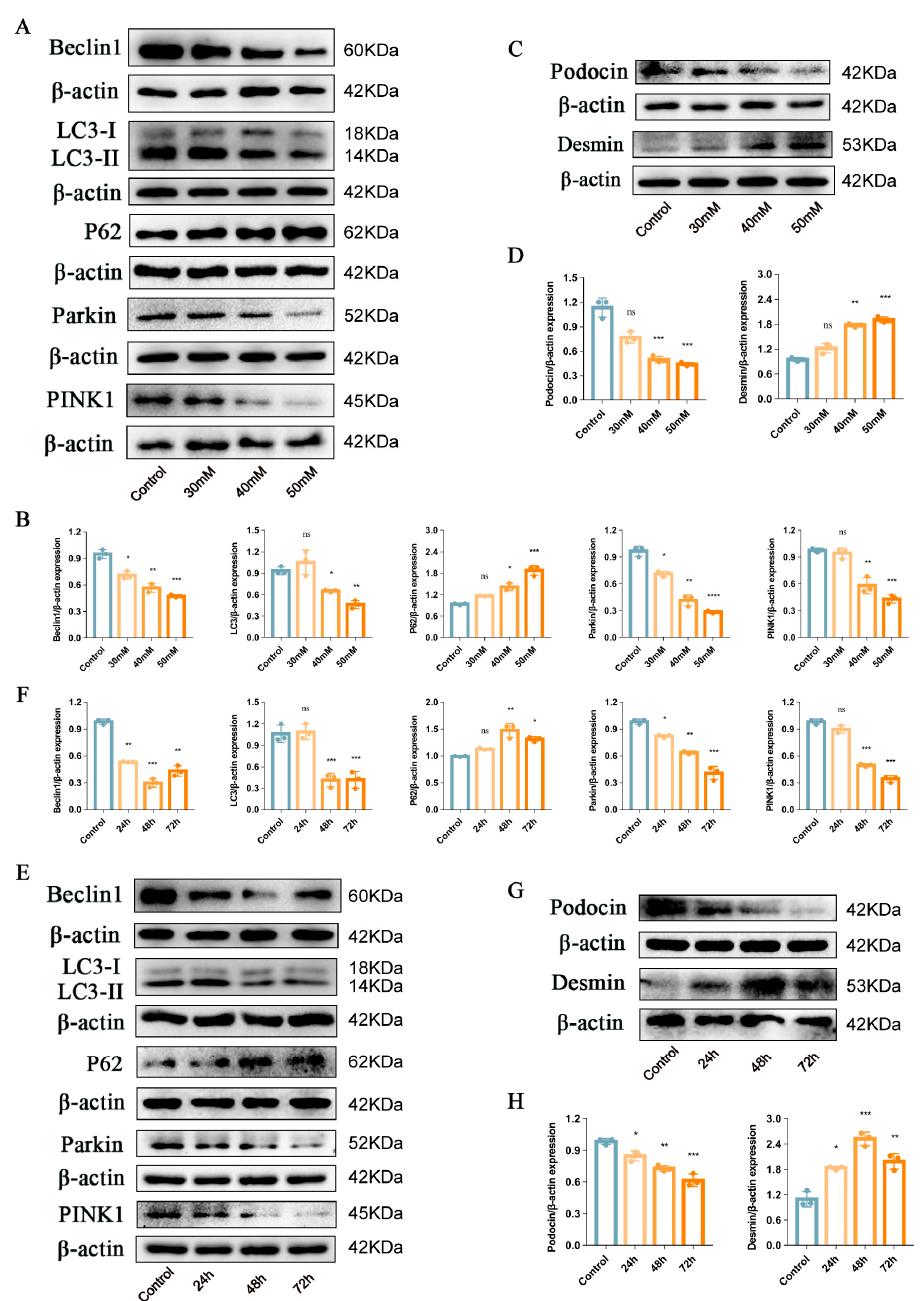
Figure 1. Podocyte injury and PINK1/Parkin-mediated mitophagy inhibition induced by HG. ( A , B ) Representative Western blot analysis of Beclin1, LC3II/LC3I ratio, P62, Parkin, and PINK1 in MPC5 treated with different concentrations of glucose. ( C , D ) Representative Western blot analysis of Podocin and Desmin in MPC5 treated with different concentrations of glucose. ( E , F ) Representative Western blot analysis of Beclin1, LC3II/LC3I ratio, P62, Parkin, and PINK1 in MPC5 treated with HG for 24 h, 48 h, and 72 h. ( G , H ) Representative Western blot analysis of Podocin and Desmin in MPC5 treated with HG for 24 h, 48 h, and 72 h. n = 3 for ( A – H ). β -actin was used as loading control. * p < 0.05, ** p < 0.01, *** p < 0.001, and **** p < 0.0001 vs. control; ns = not